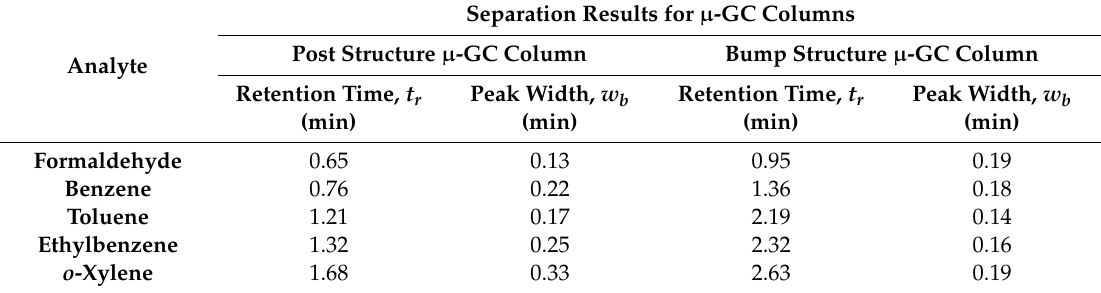
Table 1. Summary of the retention time ( t r ) and peak width at the base ( w b ), as obtained from the separation results for each column presented in Figures 6 and 7.